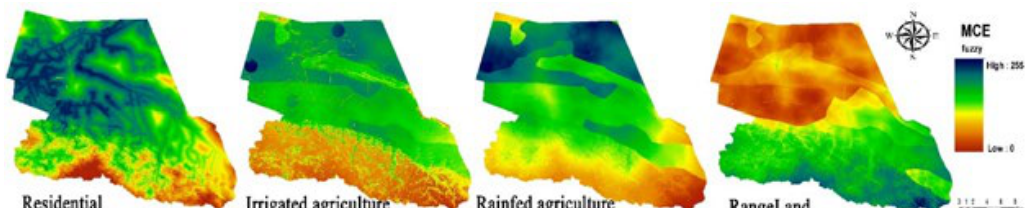
Fig. 3: Transition suitability maps for different land uses produced via MCE